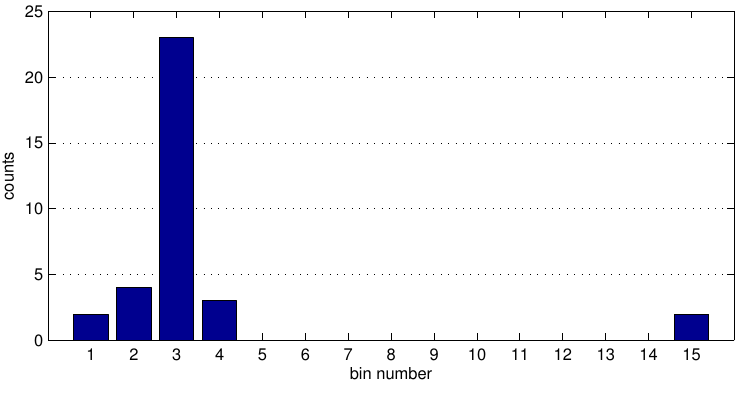
Figure 4. Bin classification and bin counts.